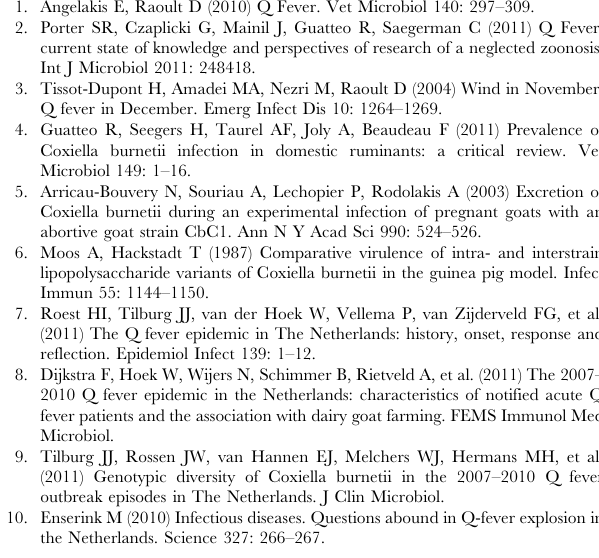
Figure S2 Adaptation of a commercially available ELISA kit for mouse anti- C. burnetii IgM and IgG quantifica- tion. Optimal serum dilution and secondary antibody complex/ conjugate concentrations was investigated by two-way titration. Titrations were conducted on negative samples (NC-dashed lines) derived from uninfected animals or from positive samples (PC-full lines) originating from C. burnetii infected mice. The applied conditions were as follows: serum dilution 1:20, anti-mouse IgM